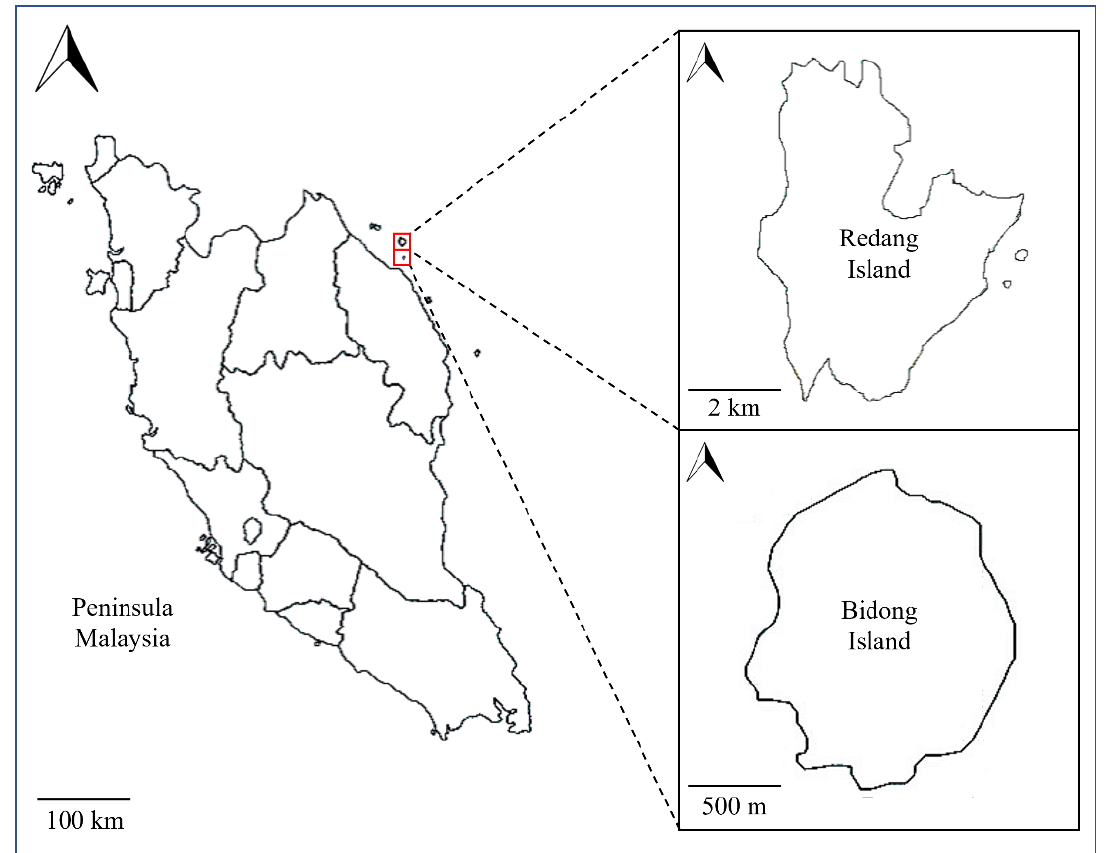
Figure 1. Map of Bidong Island and Redang Island, where marine sediment and sponges were collected.